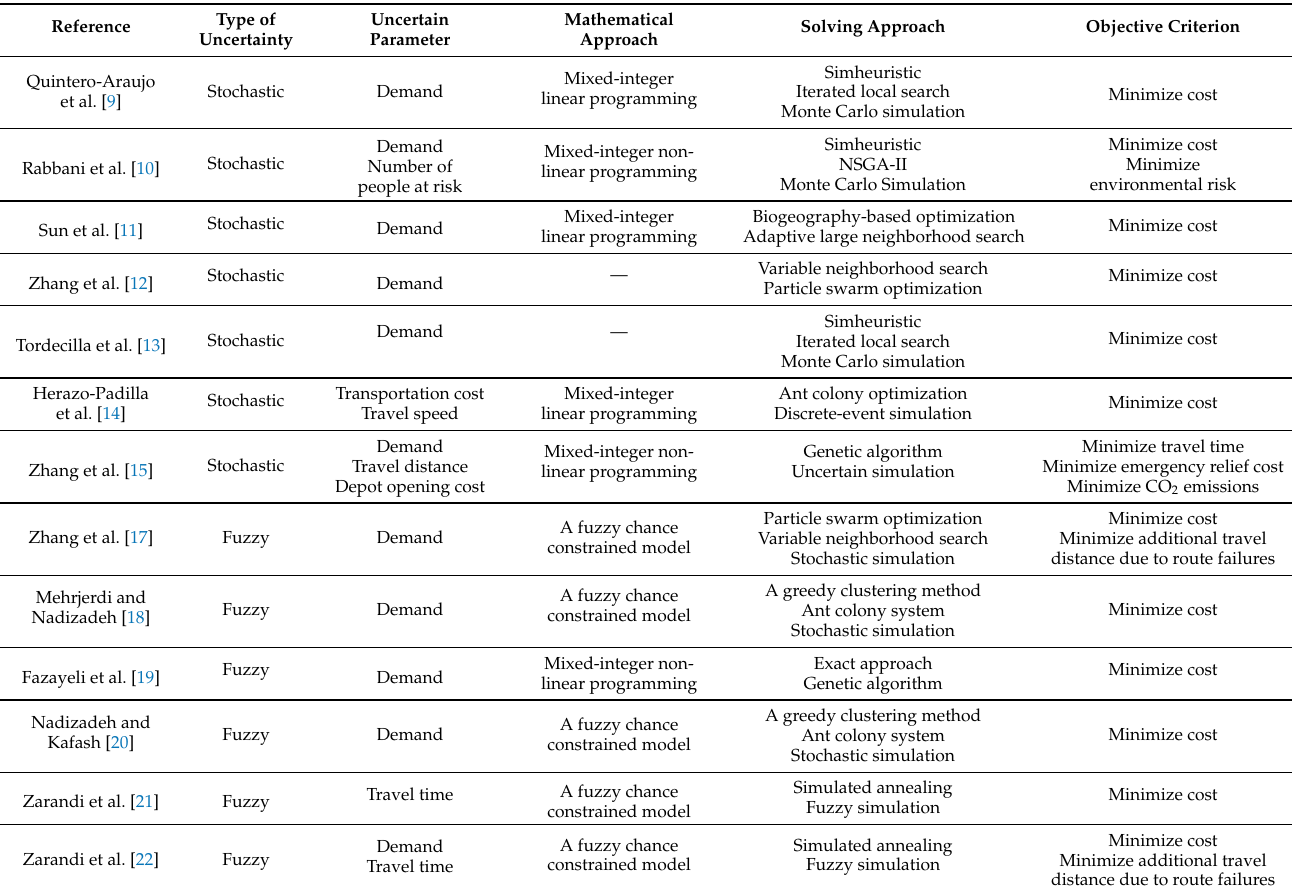
Table 1. Recent works related to the location routing problem with uncertain